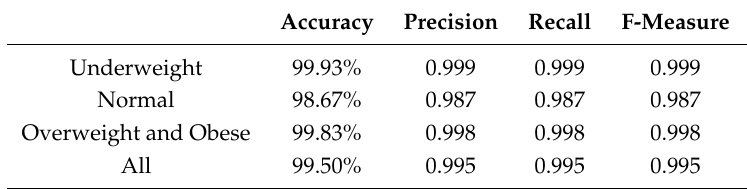
Table 10. Results with different BMI values using the BMI feature in the J48 tree.